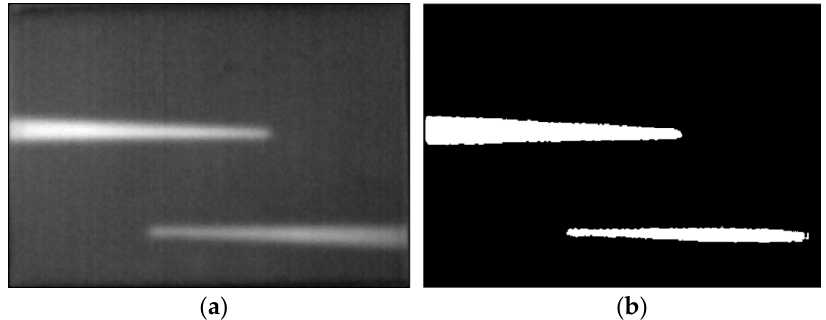
Figure 11. Image processing of image composition: ( a ) Median filter; ( b ) Segmentation by Otsu’s method.